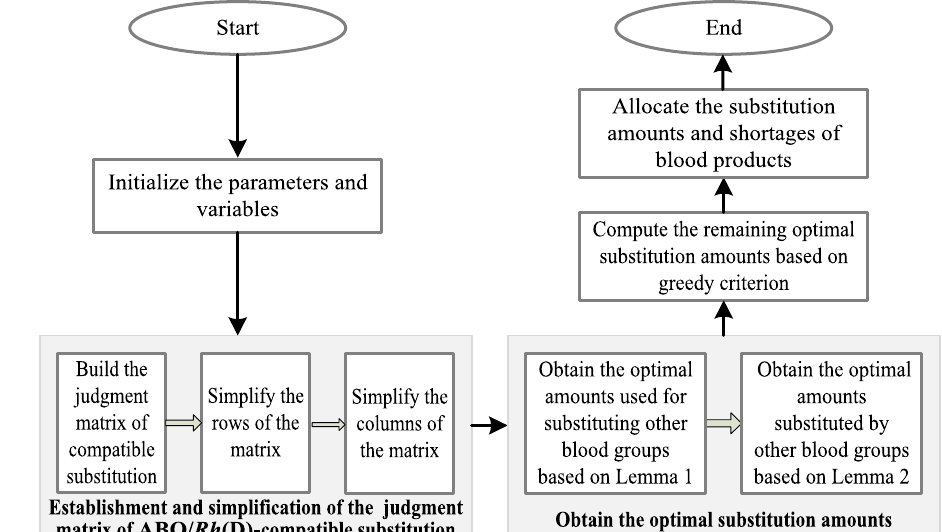
Fig. 3 Flowchart of the